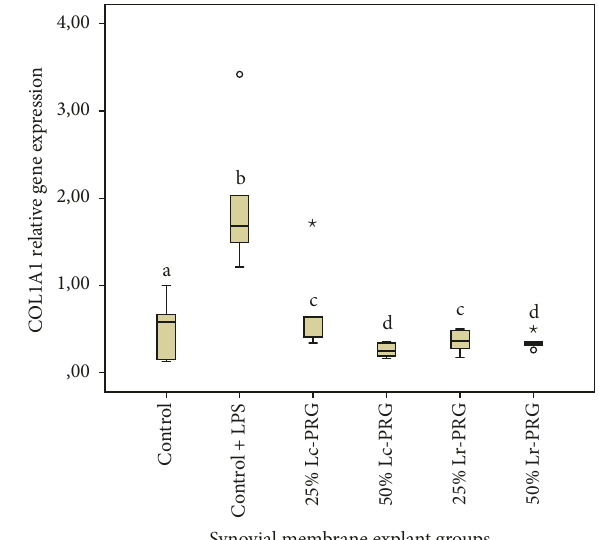
Figure 5: Box plot of median relative collagen type I alpha 1 (COL1A1) gene expression. a–d Lowercase letters denote significant differences (𝑝 > 0.05) between SME groups treated with Lc-PRG and Lr-PRG supernatants at different concentrations (25 and 50%). Groups with the same lowercase letter are not significantly different. ∘ denotes an outlier value, whereas ⋆ denotes extreme value; both symbols show nonparametric